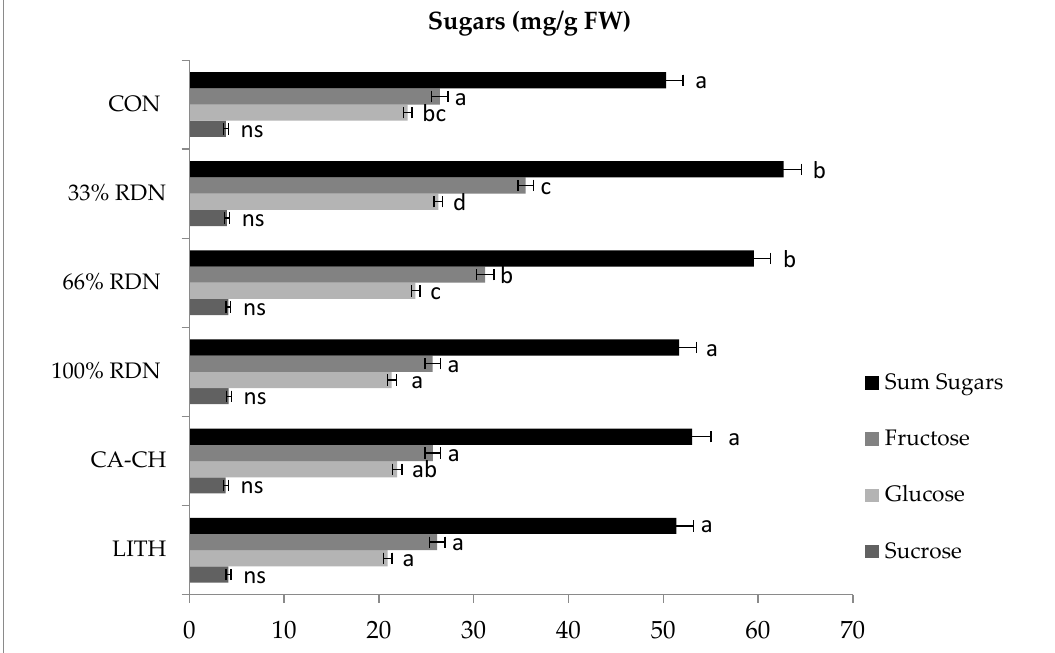
Figure 4. Strawberry organic acids content following six treatments (33%, 66% and 100% RDN, CA-CH, LITH and CON). Average means ( n = 10) ± standard errors are shown. Different letters between treatments denote significant differences (Tukey test, p < 0.05). RDN—recommended dose of nitrogen; CA-CH—calcium chelate; LITH—Lithovit; CON—control. 3.3. Content of Selected Phenolic Compounds We have identified 28 different phenolic compounds, which we divided into 5 phe- nolic groups: hydroxybenzoic acids (10), hydroxycinnamic acids (6), flavanols (3), flavo- nols (5), and anthocyanins (4). The group of hydroxycinnamic acids represented the larg- est proportion of all identified compounds (c. 39% of all identified compounds), followed